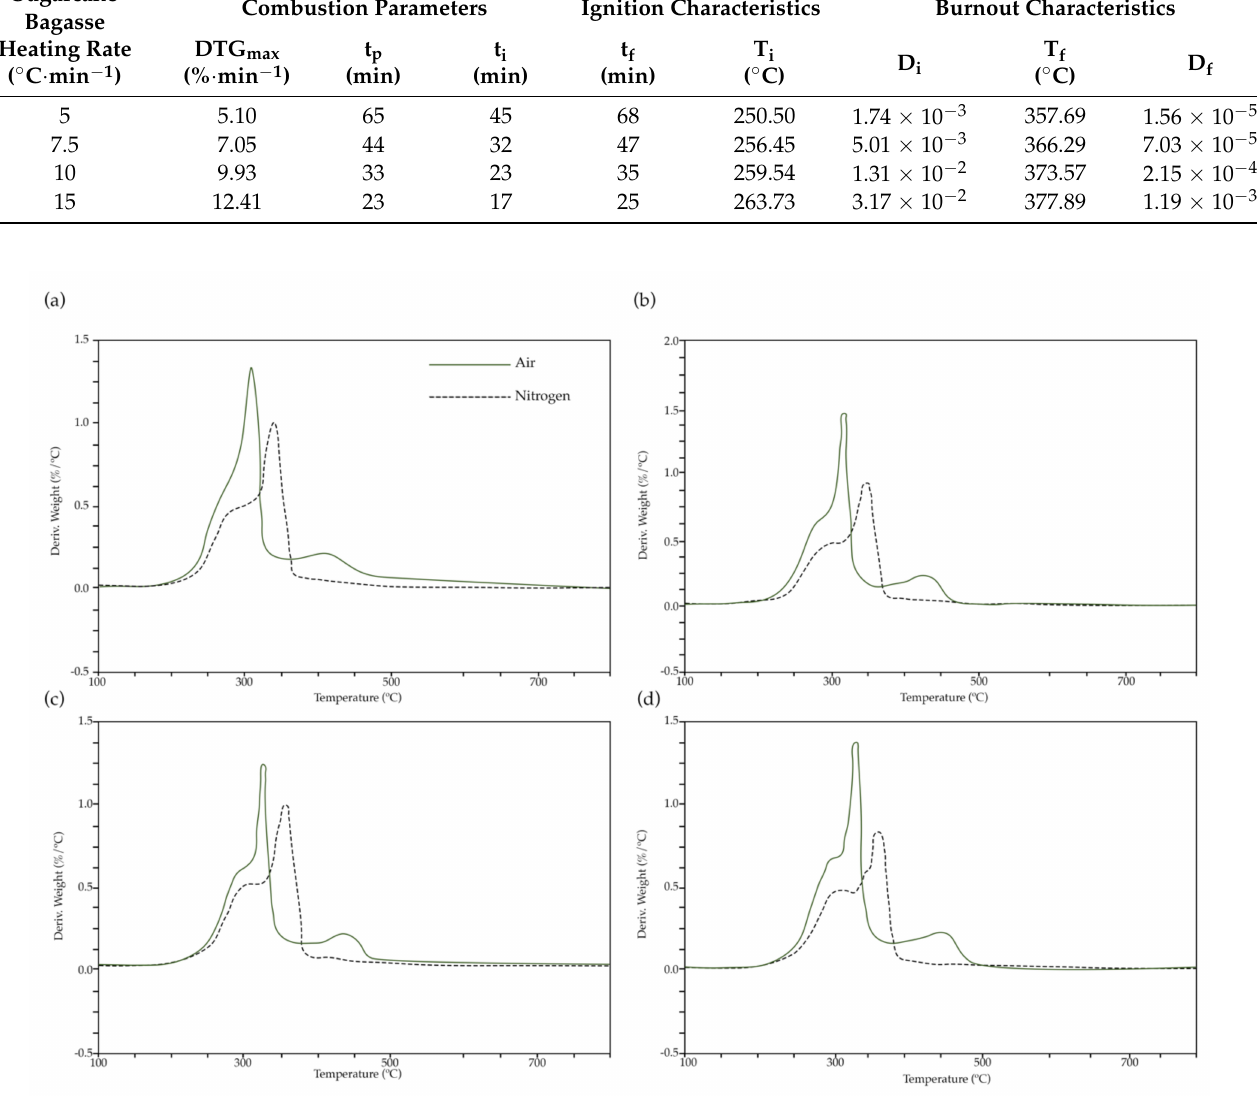
Figure 3. Distributions of DTG of sugarcane bagasse in air and nitrogen atmospheres at the heating rates of ( a ) 5; ( b ) 7.5; ( c ) 10; and ( d ) 15 ◦ C · min − 1